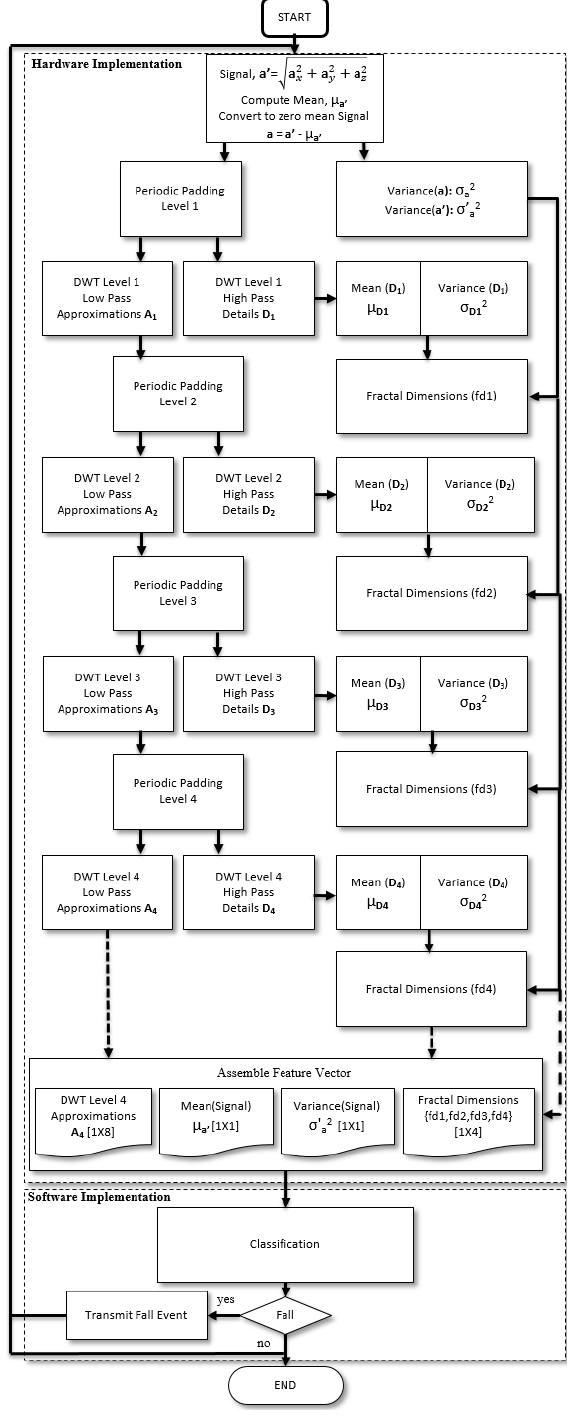
Figure 4. Flow chart of the proposed